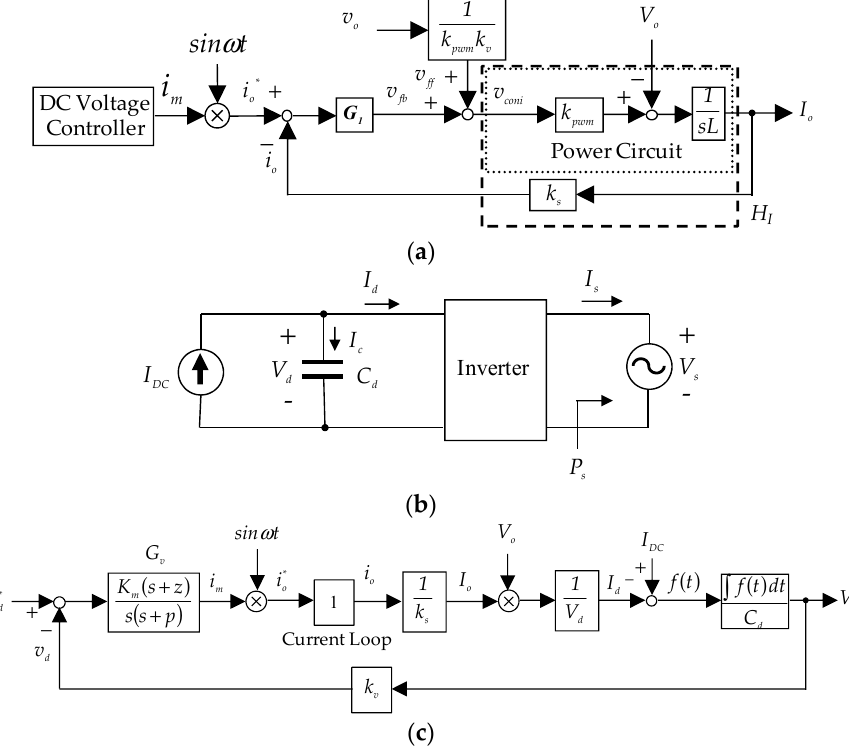
Figure 2. Block diagram of inverter control loop: ( a ) Current control loop; ( b ) DC voltage equivalent circuit; ( c ) DC voltage control loop.